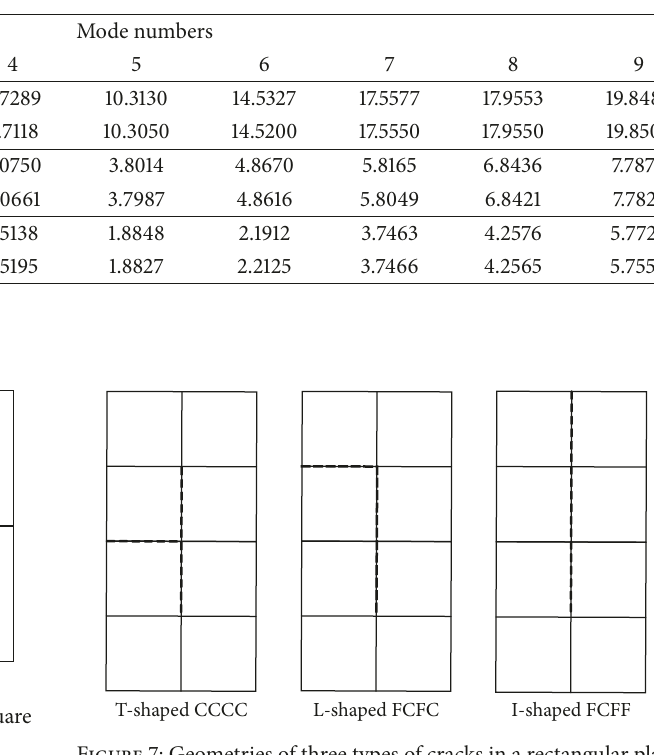
Table 1: Natural frequencies of rectangular plates with several classical boundary conditions and T-shaped, L-shaped, and I-shaped cracks.